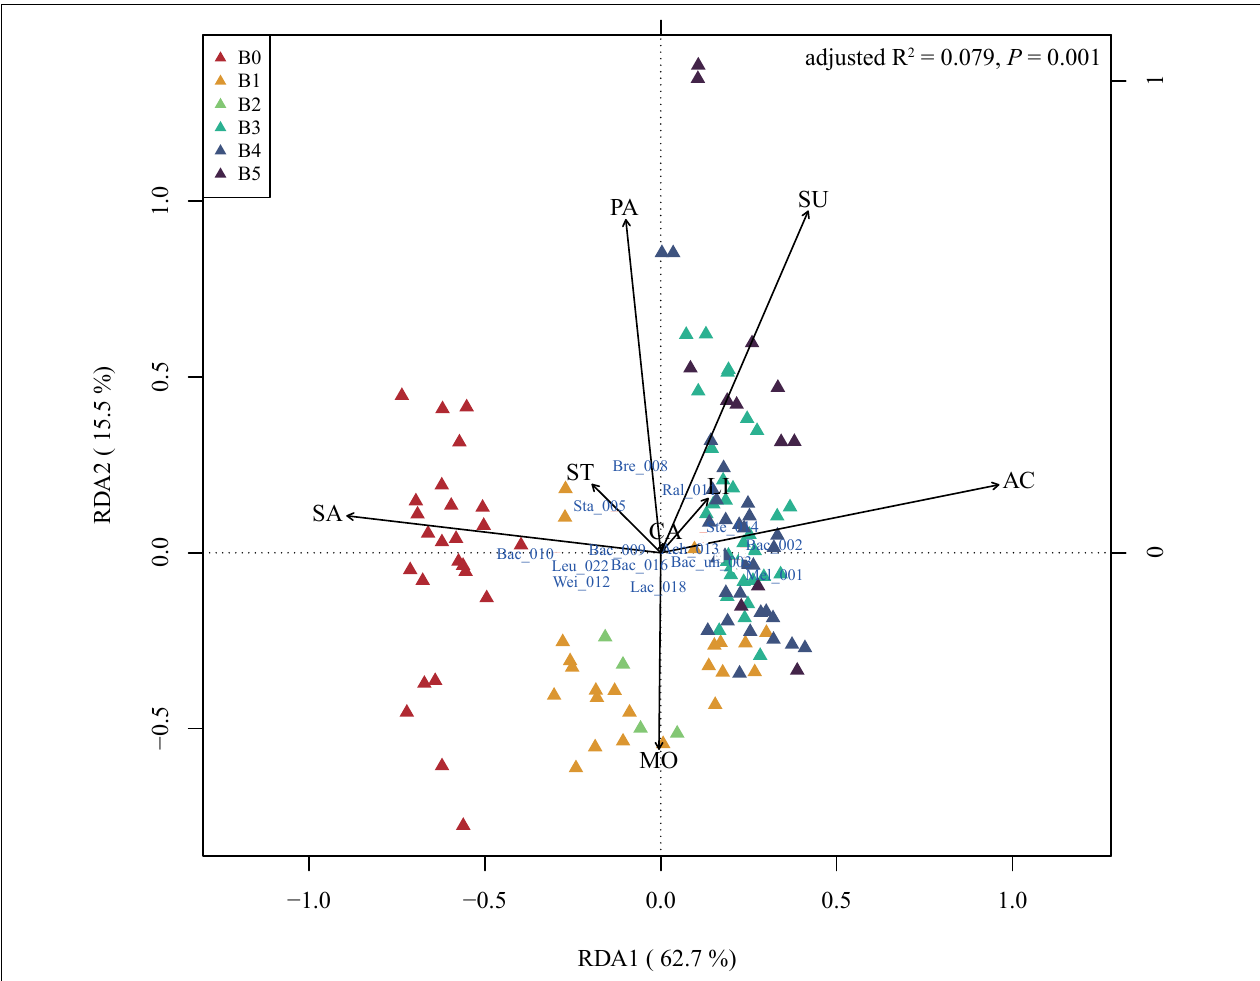
FIGURE 3 | The redundancy analysis (RDA) triplot of the 126 mature samples. Hellinger-transformed OTUs table, constrained by eight physical and chemical properties, including acidity (AC), reducing sugar (SU), moisture (MO), starch (ST), saccharification (SA), liquefaction (LI), protease activity (PA), and cellulase activity (CA). The labels of OTUs are composed of the first three letters of taxa and the last three number of OTUs original names, "un" means unclassified. As there are too many OTUs to present, only OTUs with (weighted) orthonormal species scores of RDA1 and RDA2 greater than 0.15 are plotted. "Mel" – Melghirimyces , "Bac" – Bacillus , "Bac_un" – Bacillales_unclassified, "Sta" – Staphylococcus , "Bre" – Brevibacterium , "Ral" – Ralstonia , "Wei" – Weissella , "Ach" – Achromobacter , "Ste" – Stenotrophomonas , "Lac" – Lactobacillus , and "Leu" – Leuconostoc . B0 to B5 stands for six batches of mature